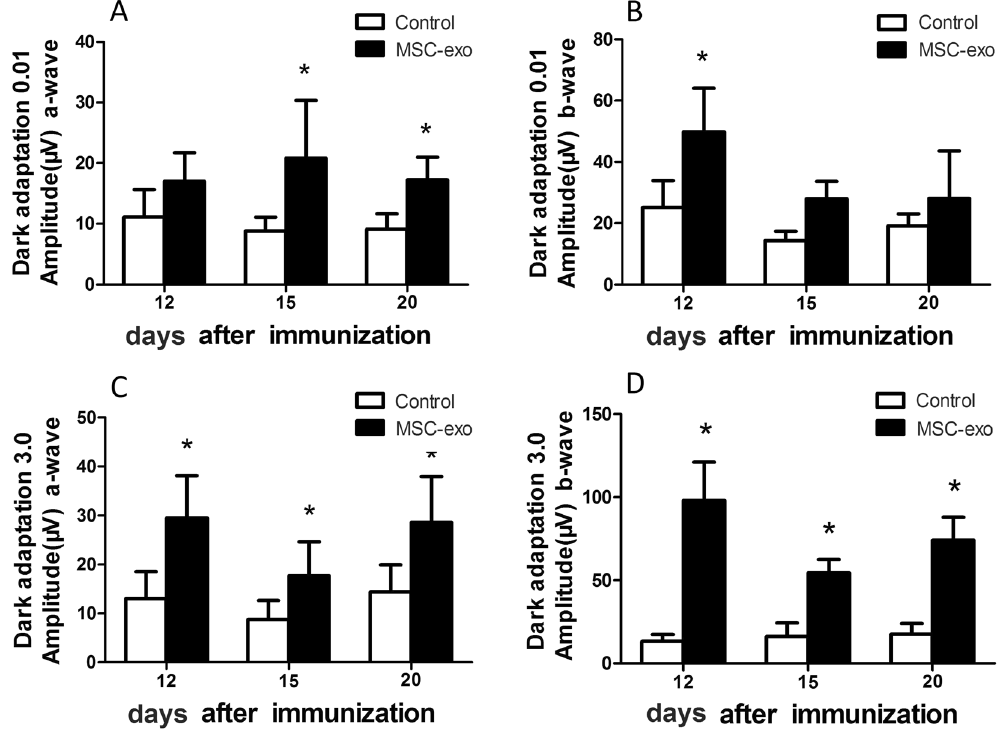
Figure 4. ERG records of the rats. ERG was carried out in both eyes and Ten responses to 0.01 and 3.0 cd × s/ m 2 white light flash (10 μ s, 0.1 Hz) from a Ganzfeld integrating sphere were amplified and averaged. A wave ( A and B ) and b wave ( C and D ) amplitudes of dark adapted ERG at 12, 15 and 20 days post immunization were analysed and compared between MSC-exo treated group and control group. Values are expressed as the mean ± SD of six rats (12 eyes) per group. * P <